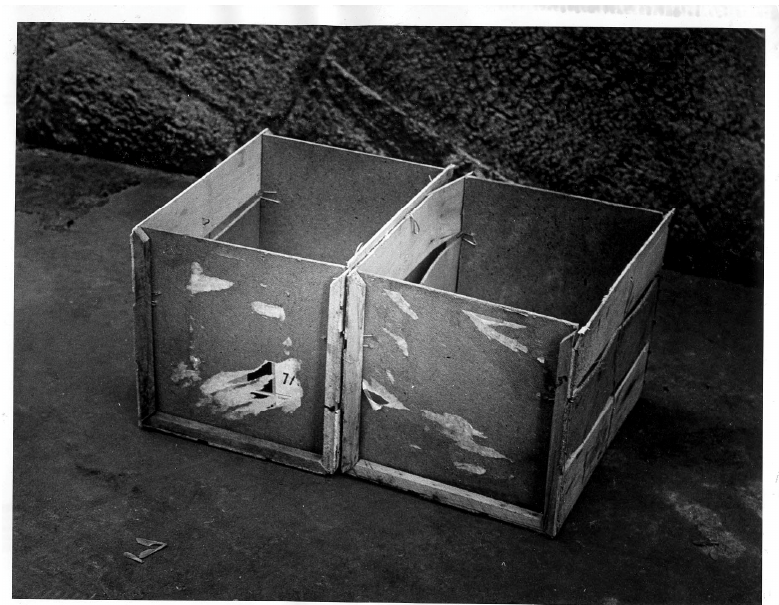
Figure 8. Skersis. You’re President. I’m President . 1979. Wood, metal, black-and-white photograph. Courtesy of the artist.